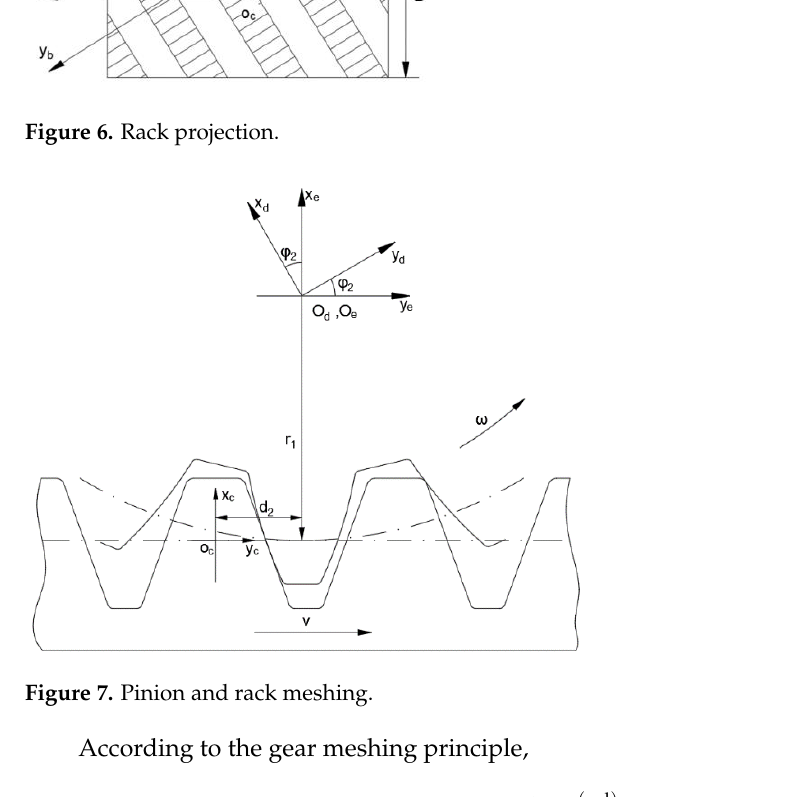
Figure 8. Diagram of axial modification.